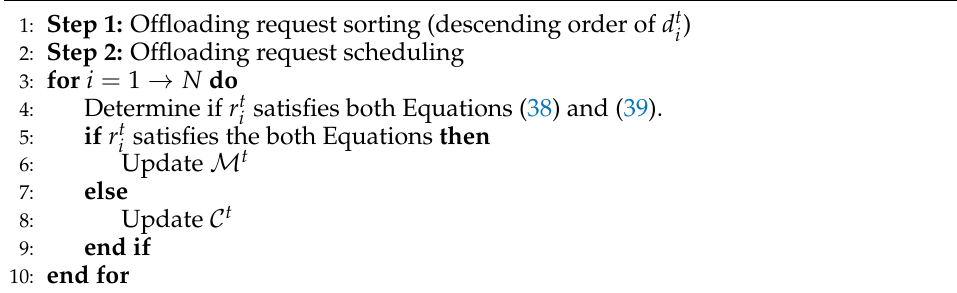
Algorithm 1 The Greedy